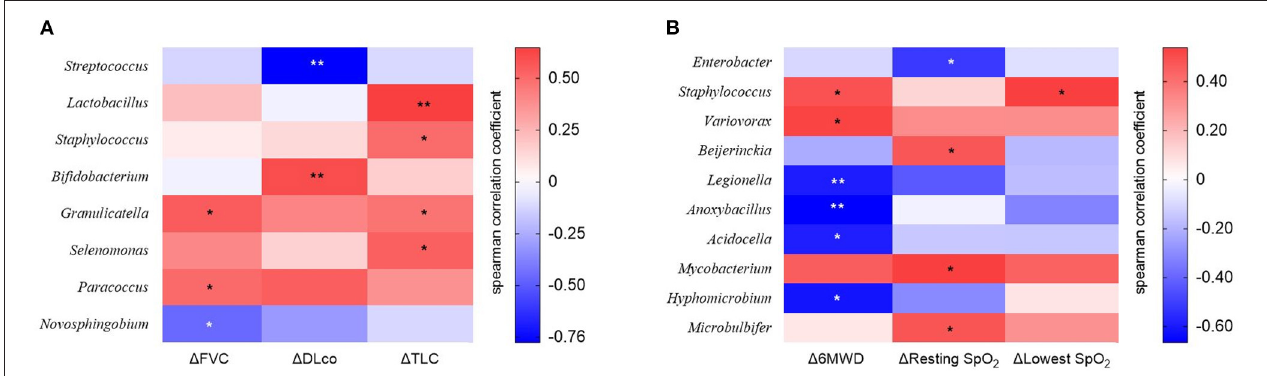
FIGURE 6 | The heatmap showing correlations between relative abundance of bacterial taxa and (A) changes in lung function or (B) exercise capacity in patients with IPF. Spearman’s correlations between the relative abundances of the bacterial genera and decline rate in lung function and exercise capacity for 1 year after diagnosis were calculated. Blue: negative correlations; red: positive correlations. * p < 0.05, ** p < 0.01. DLco, diffusing capacity of the lung for carbon monoxide; FVC, forced vital capacity; IPF, idiopathic pulmonary fibrosis; TLC, total lung capacity. 6MWD, 6-minute walk test distance; SpO 2 , oxygen saturation; 1 , decline rate for 1 year.